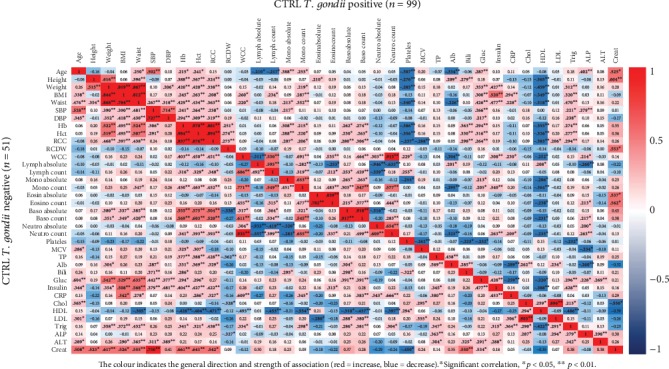
Correlation heat map with Pearson correlation coefficient values displaying the interrelationships between 37 laboratory and anthropometric parameters in control subjects with and without T. gondii infection. BHS, Western Australia.